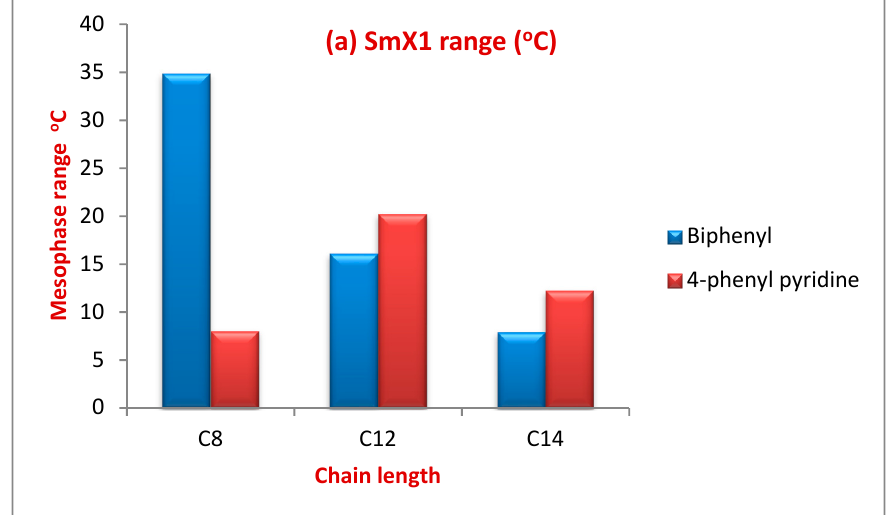
Figure 2. Mesophase textures observed by POM during heating cycle of compound 3.h; ( a ) SmX1 phase; ( b ) SmA phase.